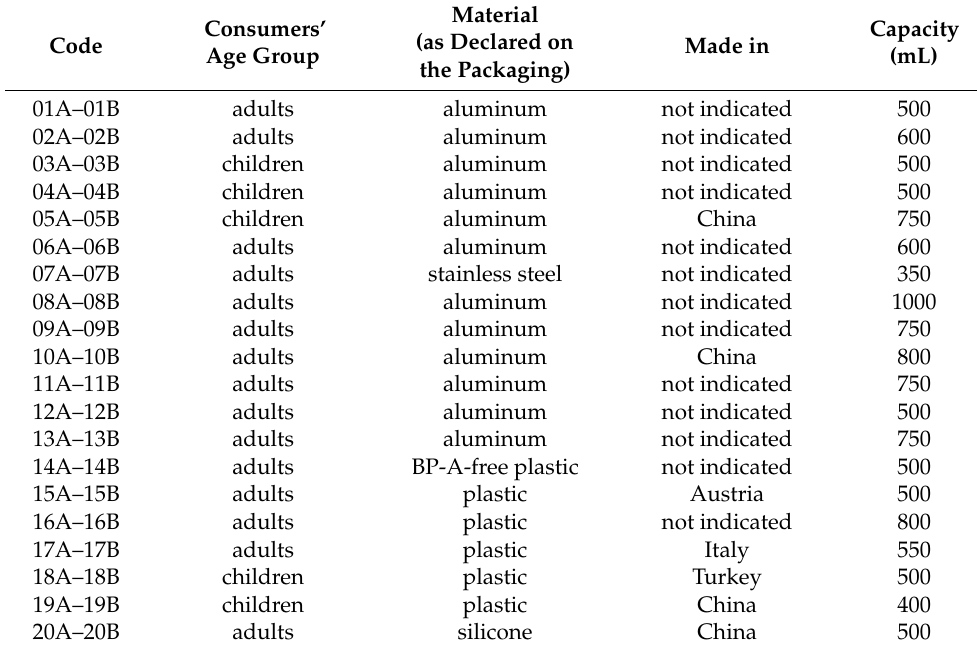
Table 1. Descriptive characteristics of the studied water bottles.